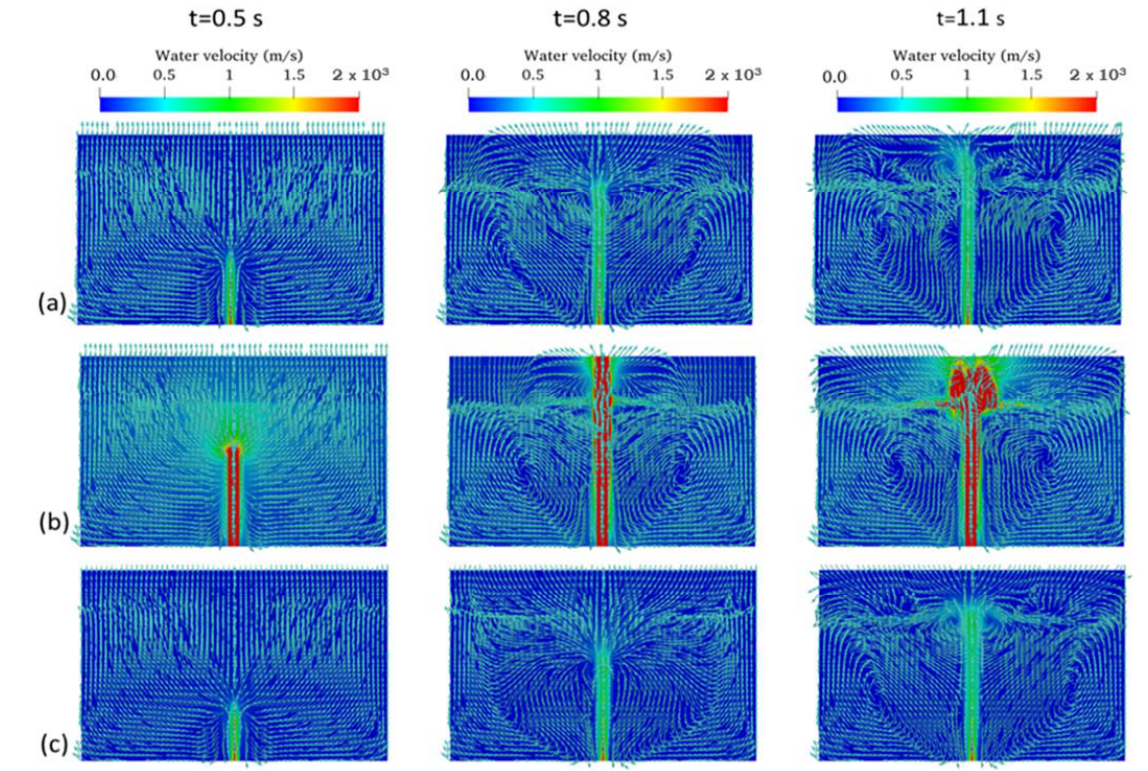
Figure 10. Water velocity distribution over the sand bed at times 0.5, 0.8, and 1.1 s for particle distributions ( a ) PSD1, ( b ) PSD2, and ( c ) PSD3.